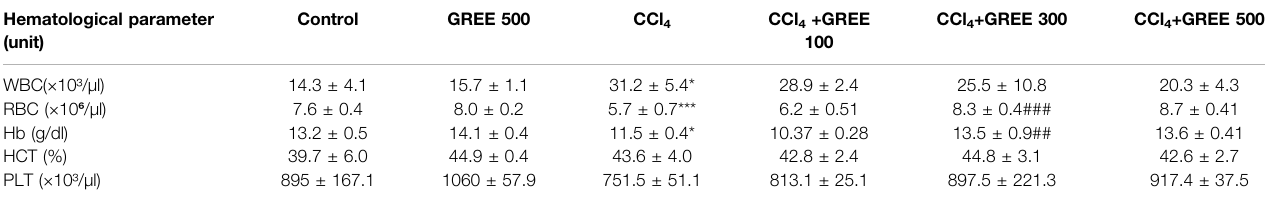
TABLE 5 | Hematological analysis of the treated groups.